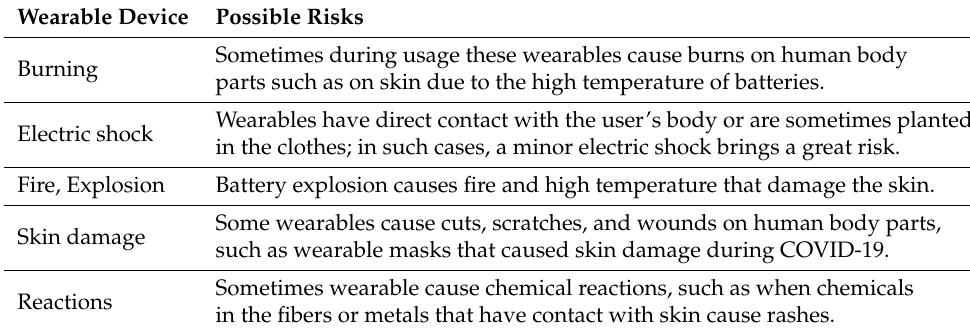
Table 3. Potential risk associated with wearable